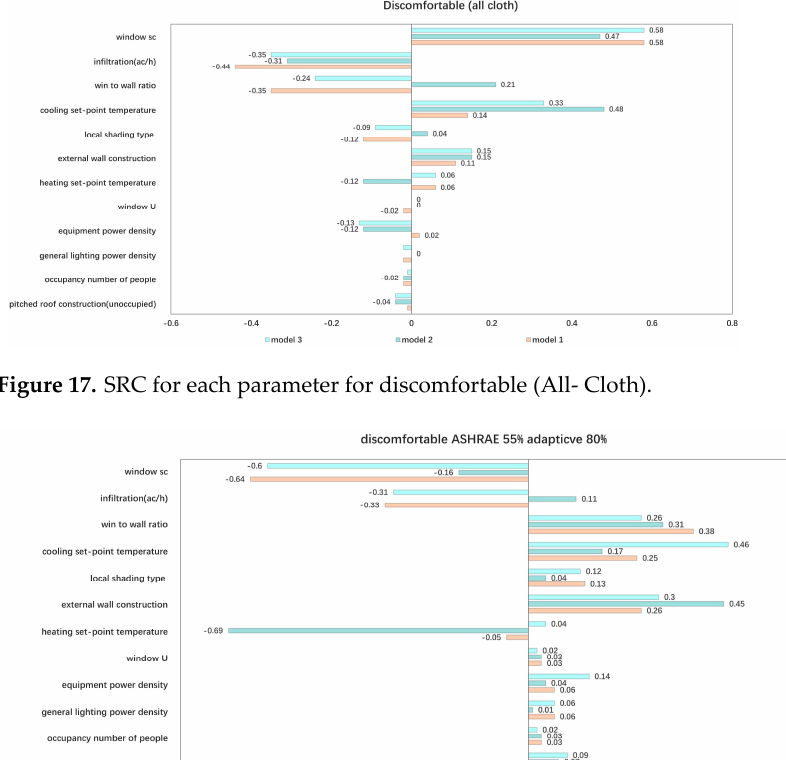
Figure 17. SRC for each parameter for discomfortable (All- Cloth).